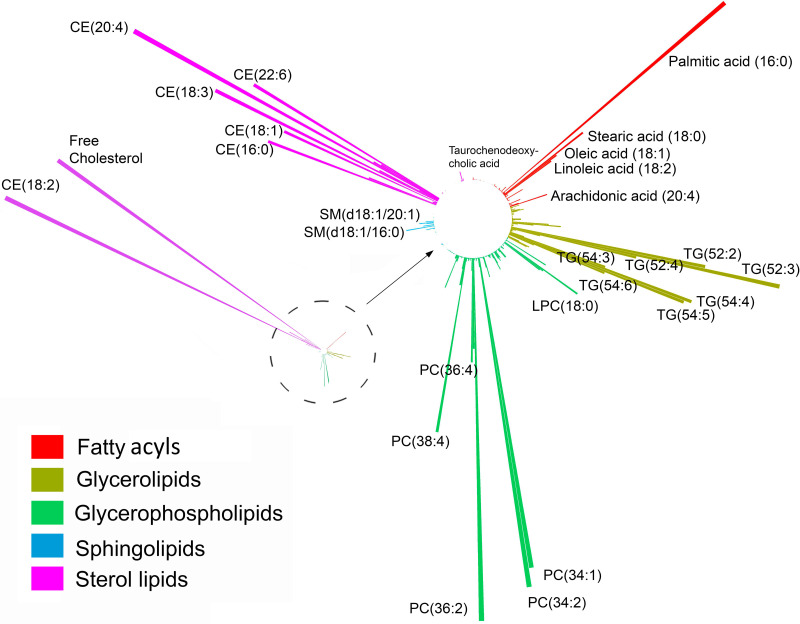
Circular barplot of the mean concentration of lipid species across 5 lipid categories measured by targeted lipidomics in Quaker parrots (Myiopsitta monachus).The dashed circle and arrow indicate the zoomed-in portion of the left barplot. Each lipid category is color coded differently. Lipid species abbreviation follows the LIPIDMAPS nomenclature. While lipid species were quantitively measured, comparisons across lipid category should be made carefully.